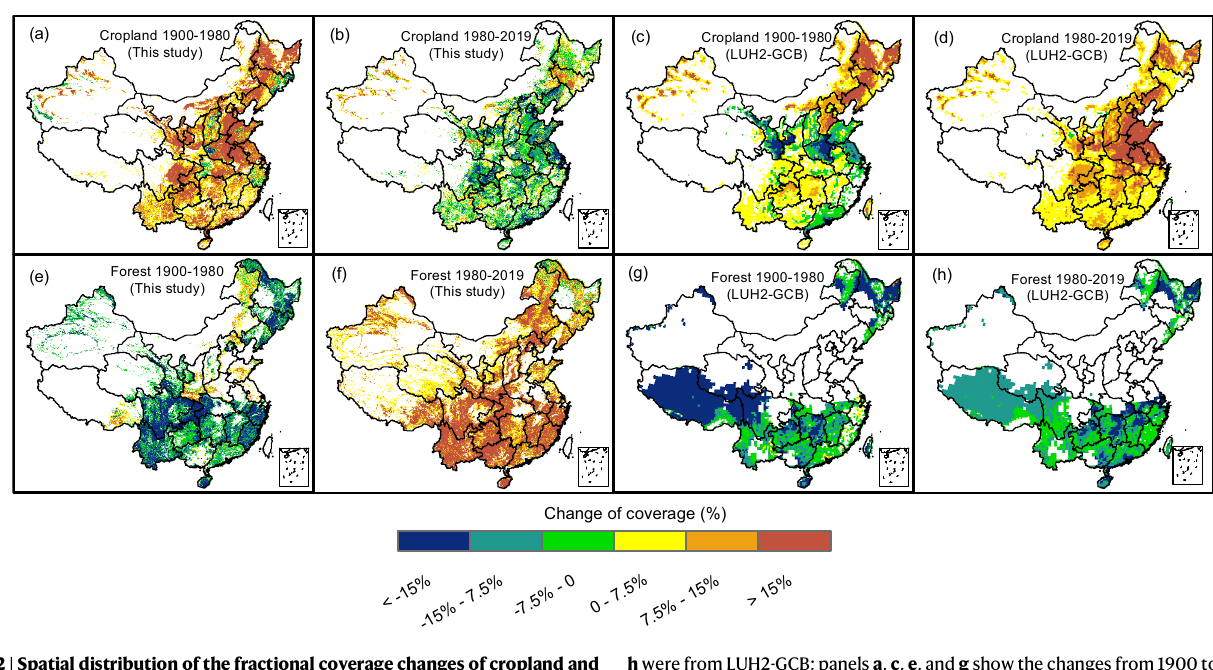
Fig. 2 | Spatialdistributionofthe fractional coveragechangesofcropland and forest in China (unit: %). Panels a – d : cropland; panel e – h : forest; panels a , b , e ,and f indicatetheresultsderivedfromthisstudy;datainpanels c , d , g ,and